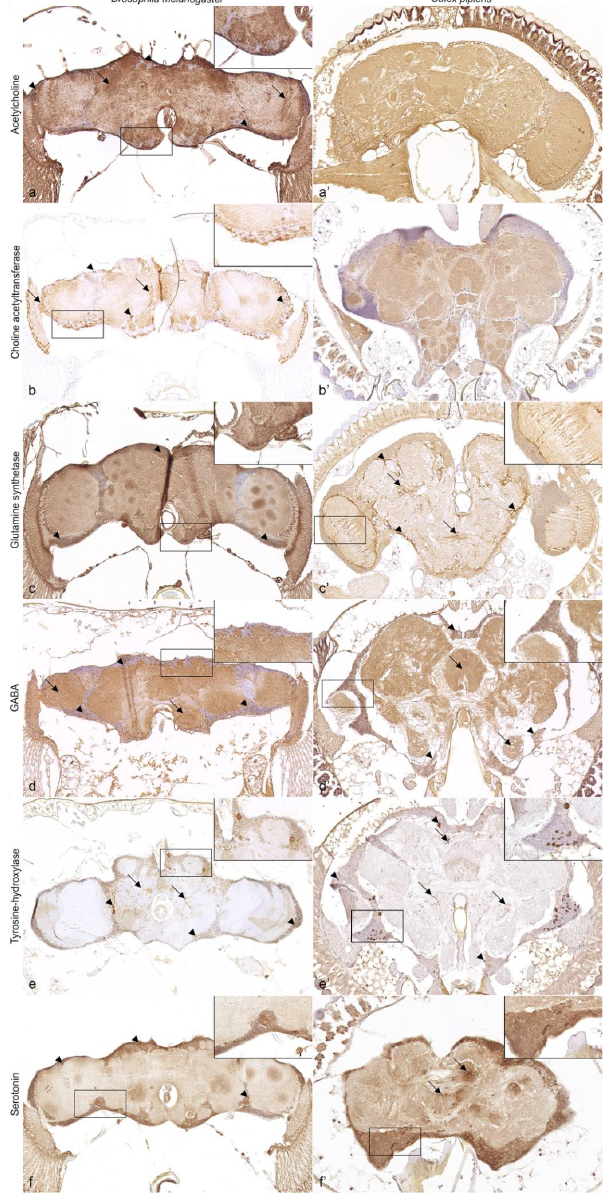
Figure 3. Immunoreactivity of antibodies directed against neurotransmitters and neurotransmitter- related enzymes in Culex pipiens in comparison to Drosophila melanogaster . A cell body (arrowheads) and neuropil-associated (arrows) immunolabeling was observed for ACh and ChAT in Drosophila melanogaster ( a , b ). In contrast, application of anti-ACh resulted in a diffuse immunosignal of cortex and neuropil in Culex pipiens ( a’ ), while ChAT-immunoreactivity was restricted to the neuropil ( b’ ). GS- immunoreactivity was multifocally present in cortical cell bodies in Drosophila melanogaster ( c ), while it was detected as a cell layer surrounding and extending short projections into the neuropil in Culex pipiens ( c’ ). GABA-immunoreactive neurons (arrowheads) as well as innervations within the neuropil (arrows) were visible in Drosophila melanogaster ( d ) and Culex pipiens ( d’ ). Note the species-specific distribution of TH-positive neurons (arrowheads) and their extensive arborization within the neuropil (arrows) in Drosophila melanogaster ( e ) and Culex pipiens ( e’ ). Multifocal immunolabeling of cortical cells (arrowheads) was observed with anti-5HT in Drosophila melanogaster ( f ), whereas 5HT-positive neurons (arrowheads) and their arborization within the neuropil (arrows) were shown in Culex pipiens ( f’ ). Magnification × 20, magnification insert × 40. 5HT: serotonin; ACh: acetylcholine; ChAT: choline acetyltransferase; GABA: γ -aminobutyric acid; GS: glutamine synthetase; TH: